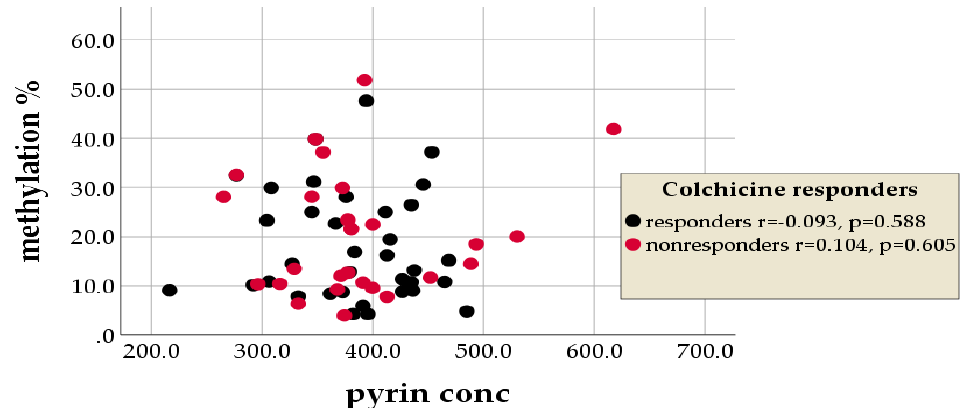
Figure 4. Correlation between the MEFV exon 2 methylation% and the pyrin concentration among FMF colchicine-responders and non-responders. Table 7. Relation of the colchicine response with different parameters in FMF